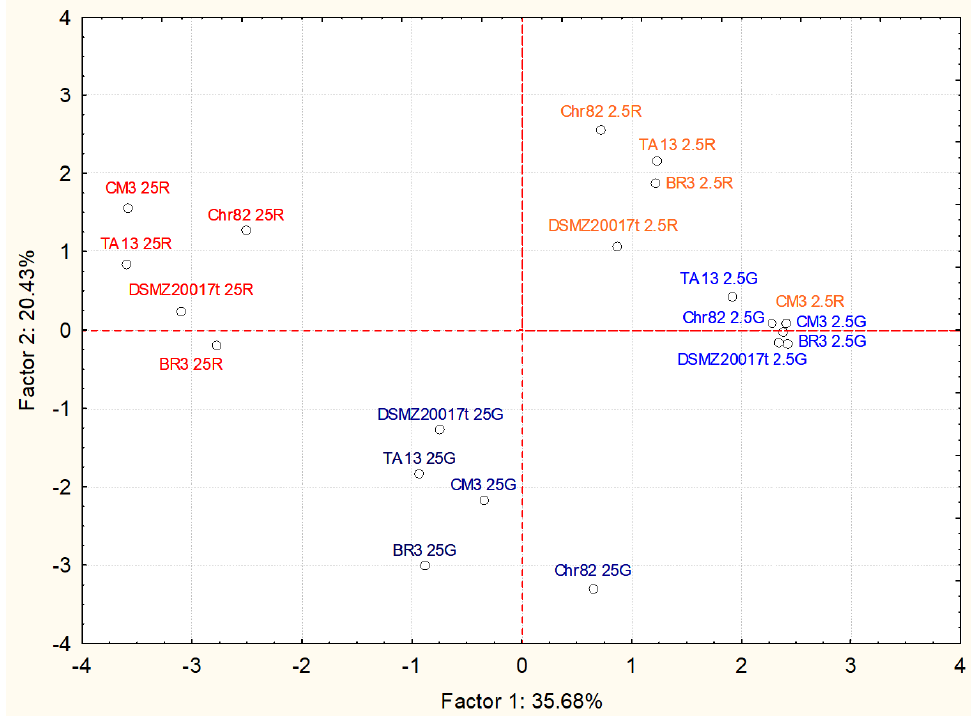
Figure 3. Results of PCA based on correlation matrix of metabolites accumulated after 24 h of incubation of the five L. sakei strains in the defined media with different sugar amounts. Projection of case coordinates on the sample score plot of the first two factors, explaining about 56% of variability. The factor 1 (35.68% of the variability) separated the 25G from the 25R driven by the contribution of acetate (factor loading −0.8773), diacetyl (−0.8770) and, to a lesser extent, ethanol (−0.6928) and pyruvate (−0.6218), as reported in Table 4. Factor 2 (20.43% of vari- ability) contributed to the discrimination of the sample containing ribose from the sample containing glucose. In particular, ornithine (loading factor 0.6543) and acetoin (0.5419) grouped the ribose samples in the upper part of the plot, while lactate (−0.7815) contrib- uted to the grouping of the glucose samples in the lower part. The alternative pathways involving pyruvate when fermentable sugars are scarce or depleted (mixed-acid fermentation) are well studied [25]. Pyruvate formate lyase (PFL) and pyruvate oxidase (POX) are key enzymes in this perspective, in the absence or pres- ence of oxygen, respectively. The accumulation of products such as formate, acetate, and ethanol is the consequence of these pathways. It is interesting to observe that these mole- cules contribute to the separation of the samples containing ribose from those containing glucose. In other words, the presence of ribose seems to stimulate alternative metabolic pathways of pyruvate. Increases in the transcription of genes involved in these pathways (pyruvate oxidase, pyruvate dehydrogenase and pyruvate formate lyase) were observed in L. sakei grown on ribose if compared with those grown on glucose [16]. These pathways are also favored by metabolic routes producing pyruvate, such as serine dehydratase, which can become crucial in the survival strategy when sugars are completely depleted [14]. Pyruvate can be directed toward the formation of acetoin and diacetyl, through the enzyme α-acetolactate synthase. In particular, the production of acetoin resulted in being